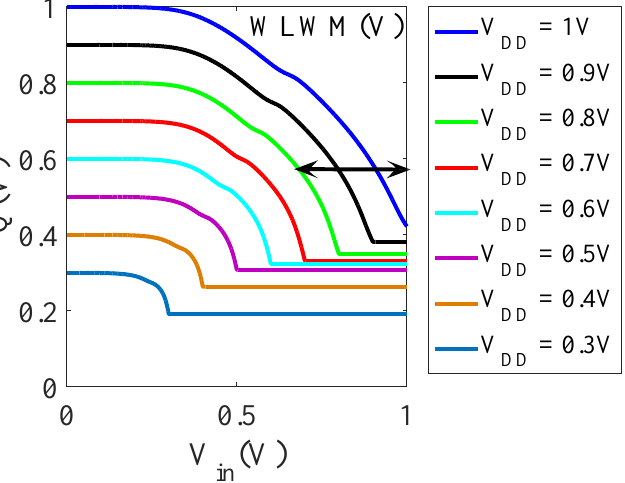
Figure 25. Word line write margin for first proposed SRAM cell at different supply voltages.